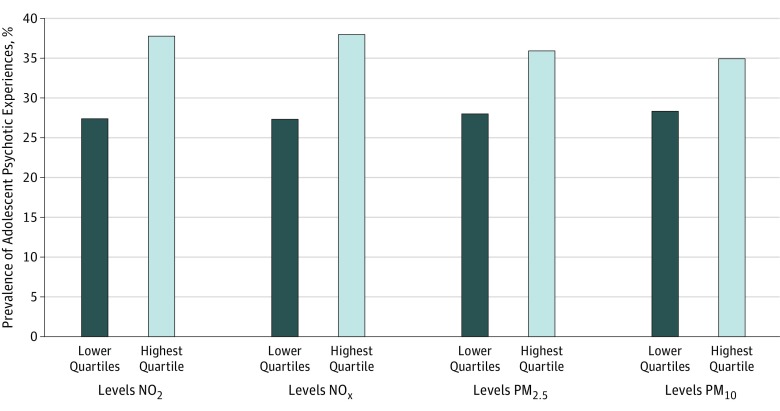
Prevalence of Adolescent Psychotic Experiences According to Exposure to Air PollutantsAir pollutants include nitrogen dioxide (NO2), nitrogen oxides (NOx), and particulate matter with aerodynamic diameters of less than 2.5 μm (PM2.5) and less than 10 μm (PM10). Prevalence of adolescent psychotic experiences is split by the highest quartile vs lower quartiles of exposure to each pollutant.